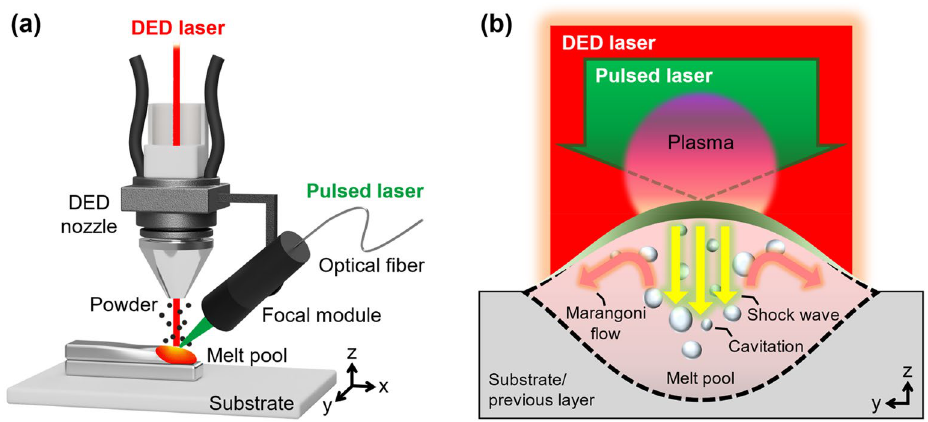
Figure 1. Pulsed laser-assisted AM (PLAAM). ( a ) Off-axis configuration of a PLAAM system. ( b ) The pulsed laser induces shock waves, cavitation, and accelerated Marangoni flow inside the melt pool, providing a favorable environment for grain